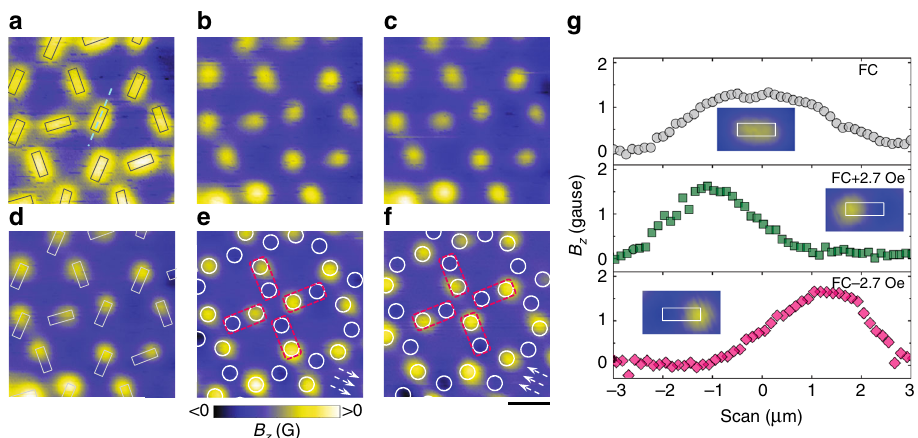
Fig. 3 Generation of the vortex-ice-like patterns by erasing positive/negative magnetic poles. a SHPM images taken after fi eld cooling to 4.2 K at fi rst matching fi eld H 1 ( a ), followed by a change of the external fi eld to H 1 + 0.6 Oe ( b ), H 1 + 1.2 Oe ( c ), H 1 + 2.1 Oe ( d ), H 1 + 2.7 Oe ( e ), H 1 -2.7 Oe ( f ). At each antidot, the induced screening current generates a magnetic dipole which overlaps with the magnetic fi eld of a pinned vortex. The negative pole is annihilated while the positive pole is strengthened. In a and d , the rectangles indicate the positions of antidots. In e and f the white circles mark the positions where the positive and negative poles are expected to form. Due to the annihilation of negative poles with part of the positive fi eld, corresponding to the pinned vortices, only positive poles are observed. At the vertex formed by four pairs of poles (indicated by dashed rectangles), two magnetic poles sit close to the vertex while the other two are located away from the vertex. The con fi guration is analogous to the vortex ice state. The arrows indicate the local direction of the supercurrent. Scale bar, 4 μ m. g Magnetic fi eld H 1 along the long axis of an antidot as indicated by the dashed line in a at magnetic fi elds equal to H H + 2.7 Oe (squares) and H 1 (circles), 1 1 -2.7 Oe (diamonds). The insets show the SHPM images of one antidot at the